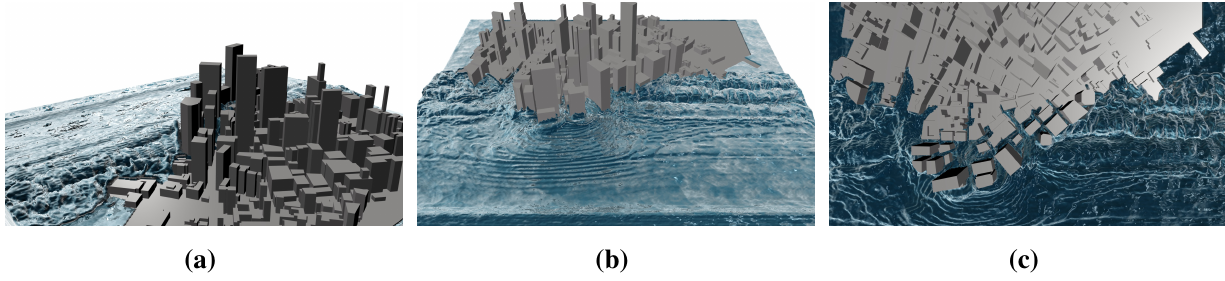
Figure 11. Wave impact on South Manhattan: results. ( a ) Northwest view; ( b ) south view; ( c ) top